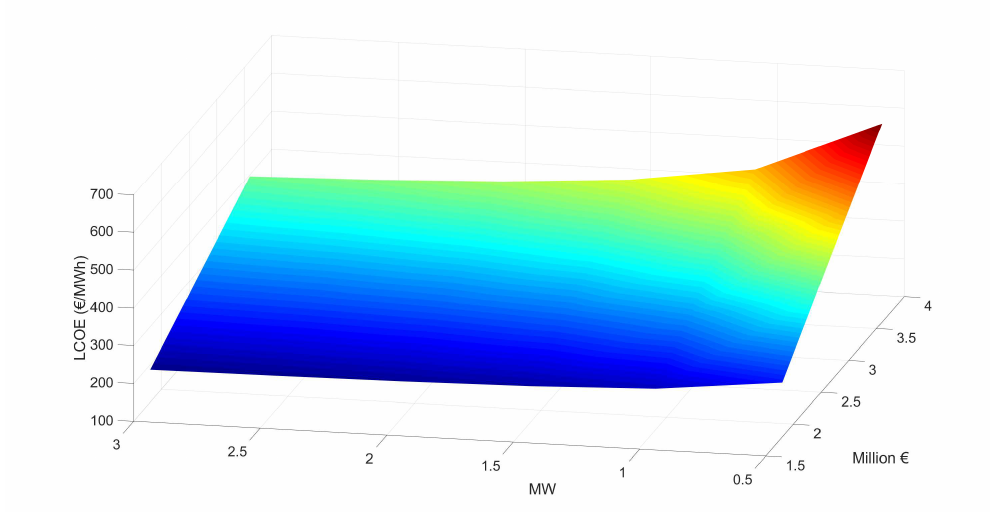
Figure 5. LCoE for breakwater of the OWC with estimations based off the Port of